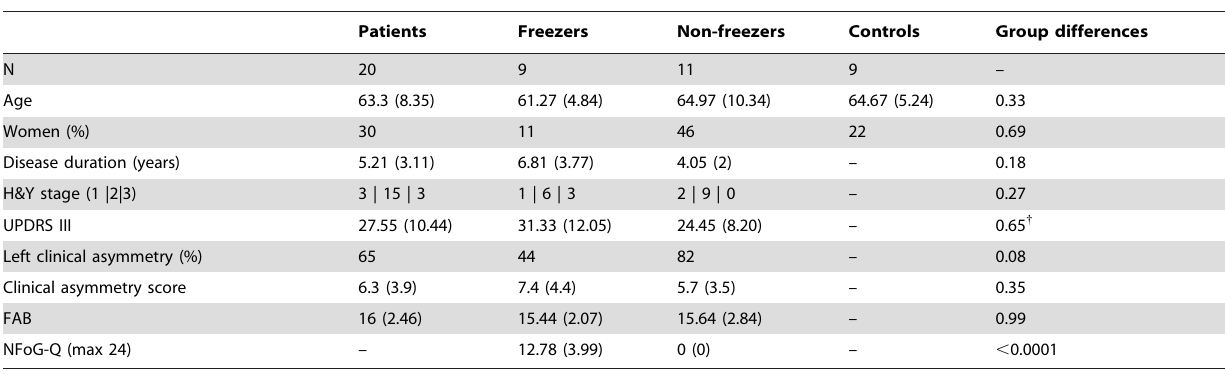
Table 2. Participant